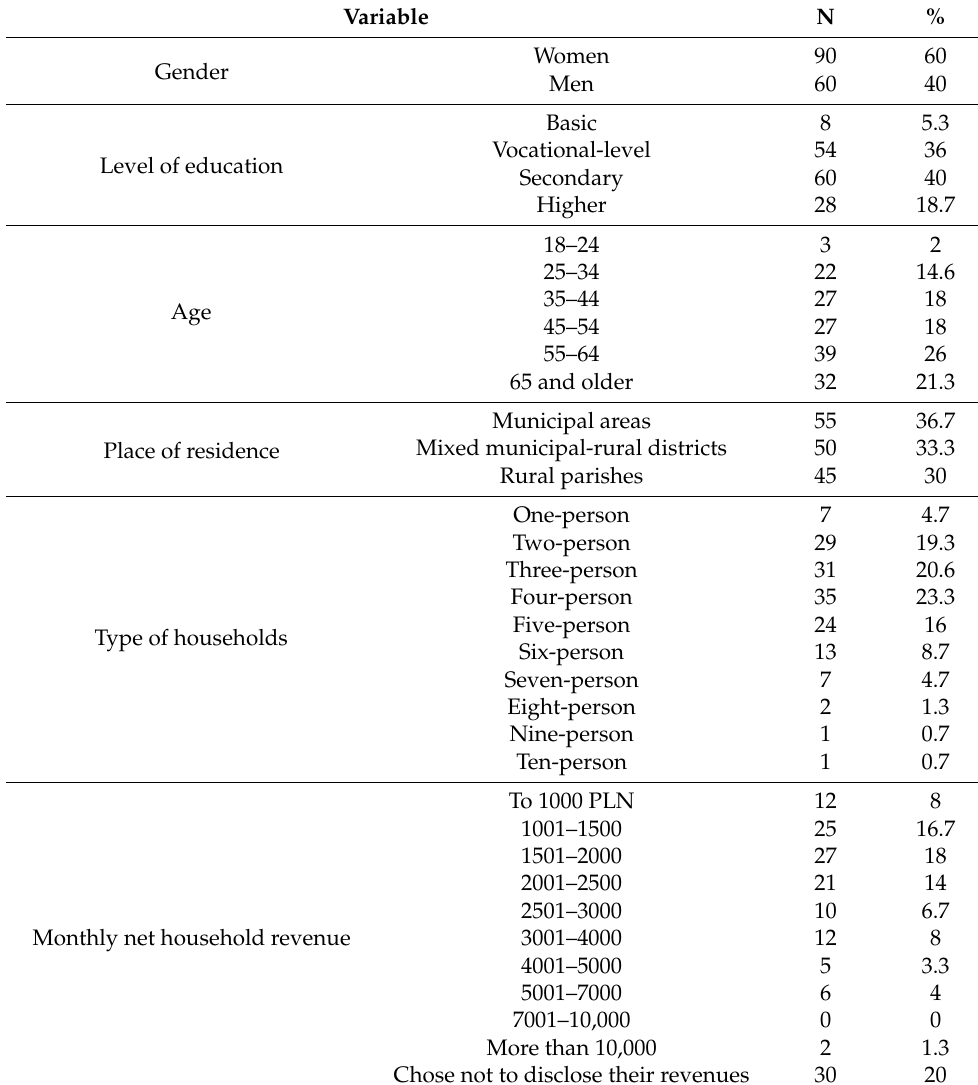
Table 4. General presentation of homo